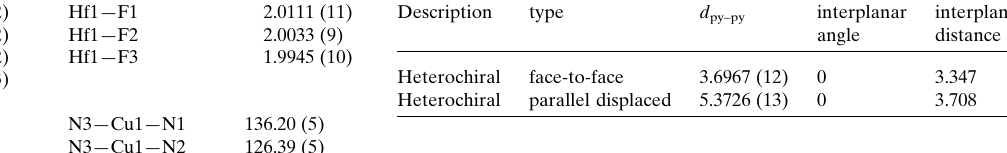
Table 6 Aromatic (cid:2) – (cid:2) stacking interactions (A˚ , (cid:4) ) in (II).